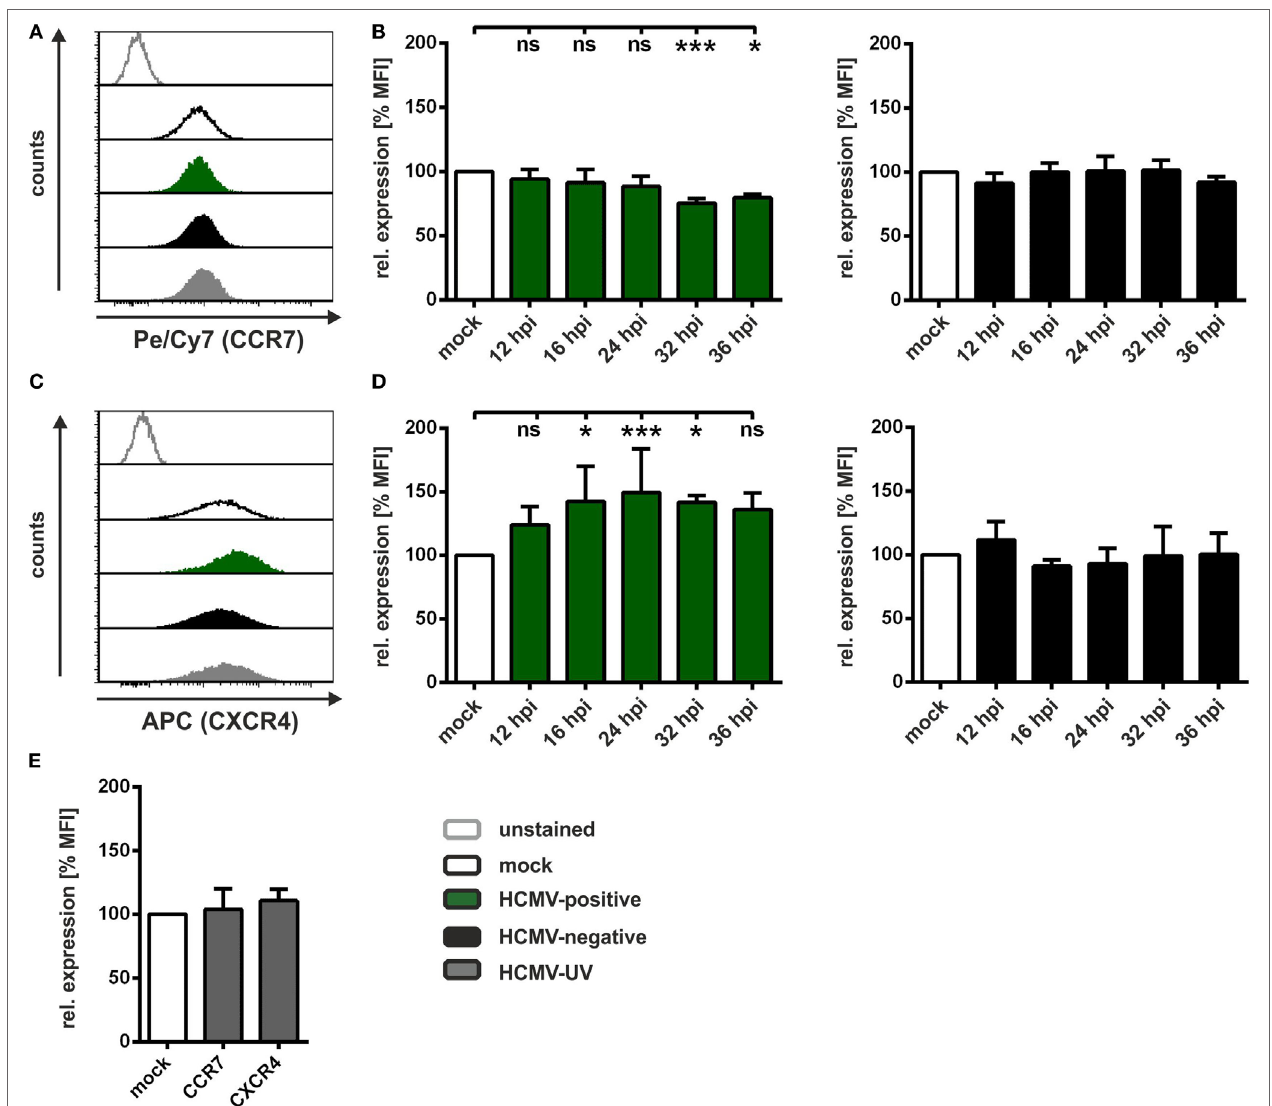
FigUre 2 | human cytomegalovirus (hcMV) differentially modulates ccr7 and cXcr4 surface expression on infected mature Dcs (mDcs) . Mock-, HCMV- or HCMV-ultraviolet (UV)-infected mDCs were harvested at the indicated time points and stained with antibodies specific for CCR7 and CXCR4 for flow cytometric analyses. (a) Representative data of one donor are shown for surface expression of CCR7 and (c) CXCR4 24 hpi. Mock cells (black histogram), HCMV-positive cells (filled green histogram), HCMV-negative cells (filled black histogram), and HCMV-UV-infected cells (filled gray histogram) are depicted. (B) Time kinetics of CCR7 and (D) CXCR4 surface expression are shown as mean fluorescence intensity (MFI) of HCMV-positive (green bars, left panel) and HCMV-negative mDCs (black bars, right panel) relative to mock cells (white bars, set to 100%). (e) CCR7 and CXCR4 surface expression of HCMV-UV-infected mDCs (gray bars) 24 hpi are shown as MFI relative to mock condition (white bar, set to 100%). The experiment was performed at least three times with cells from different healthy donors. Significant changes (*** = p < 0.001; * = p < 0.05) are indicated by asterisks, non-significant changes ( p > 0.05) as